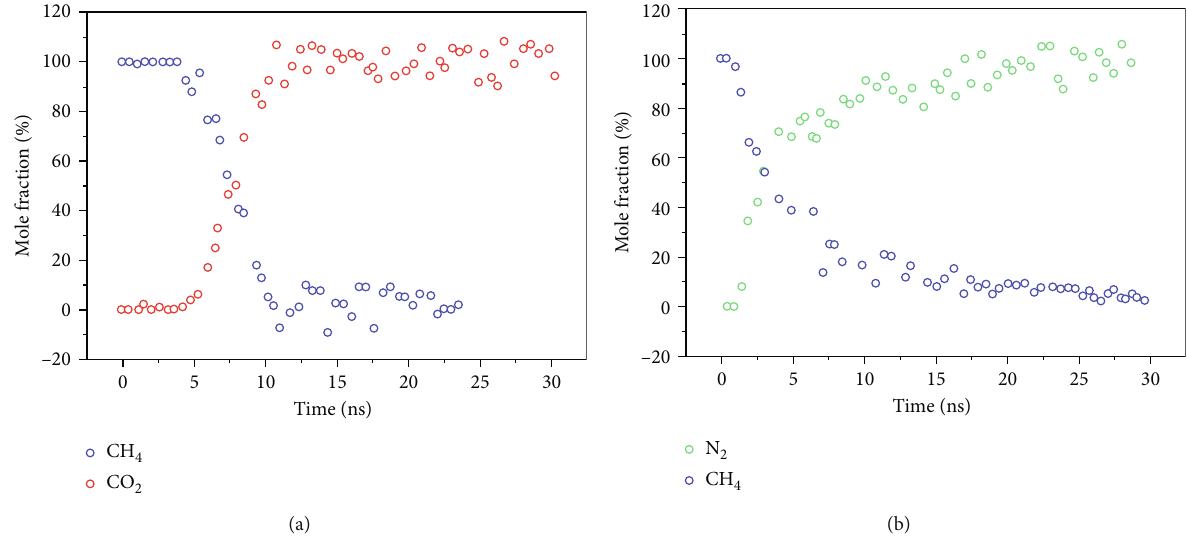
Figure 10: Displacement gas composition recorded from the MD as a function of displacement time. (a) CO displacing CH 4